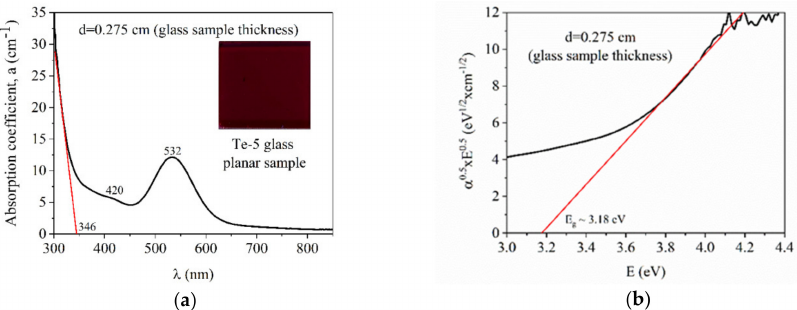
Figure 2. ( a ) The optical absorption of the Te-5 glass sample (inset-planar glass sample image) and ( b ) the graphical determination of the energy band gap, E g .